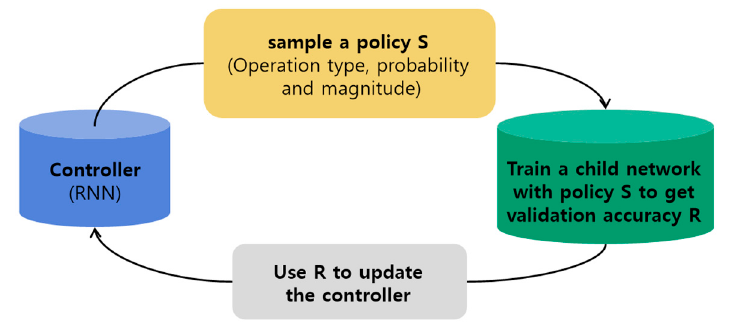
Figure 7. Process of Google’s